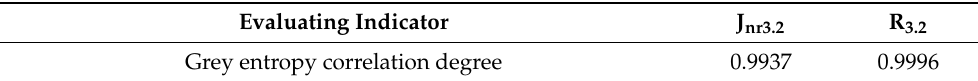
(4) Calculate the grey correlation entropy and the grey entropy correlation degree. Substituting the calculation results of the grey correlation coefficient between each comparison sequence and reference sequence in (3) into Equations (13) to (15), the calcula- tion results of the grey entropy correlation degree between other rheological performance indices of emulsified asphalt mastics and the G ∗ / sin δ can be obtained, as shown in Table 9. Table 9. Calculation results of grey entropy correlation degree.